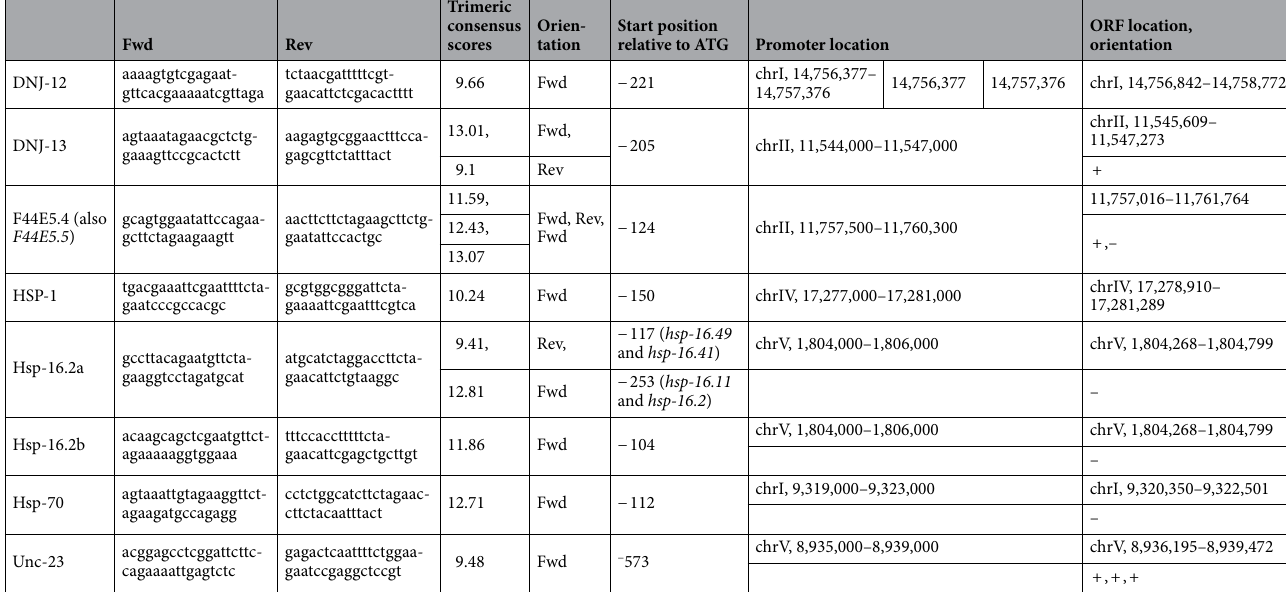
Table 6. HSE-containing probes designed from the promoter sequences of chaperone genes and used in the binding studies. The designed probes originate from the 1000 bp promoter sequence and are positioned as indicated. The strand and anti-sense strand were synthesized and combined to give the promoter sequence able to bind